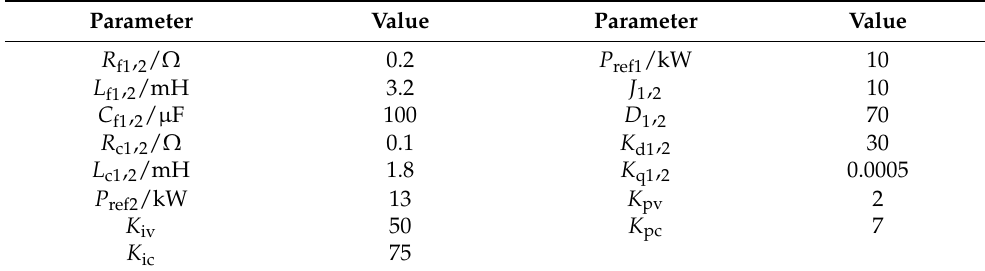
Table 4. Multi-VSG system